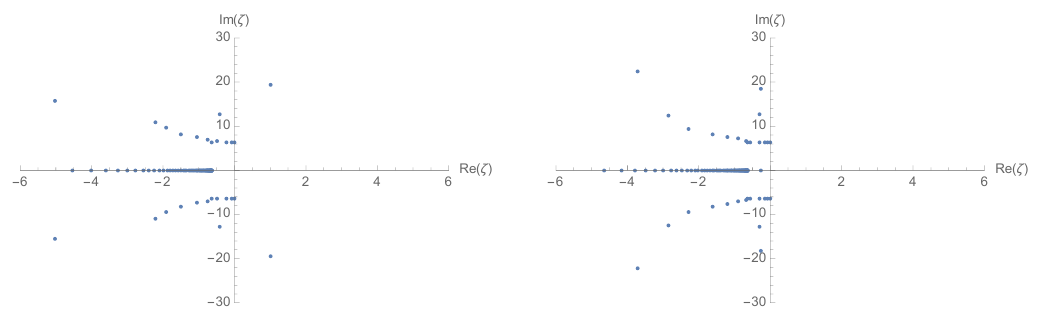
Figure 1 . The pole structure of Q n ( (cid:16) ) for n max = 100 (left) and for n max = 120 (right) in the max (cid:12)gure-eight knot complements. Some of poles depend on n max , and they should not be the true singularities of B Z conj ( (cid:16) ). In the current case, we can conclude that B Z conj ( (cid:16) ) does not have any pert pert singularities on the positive real axis but has on the negative real axis and on the imaginary